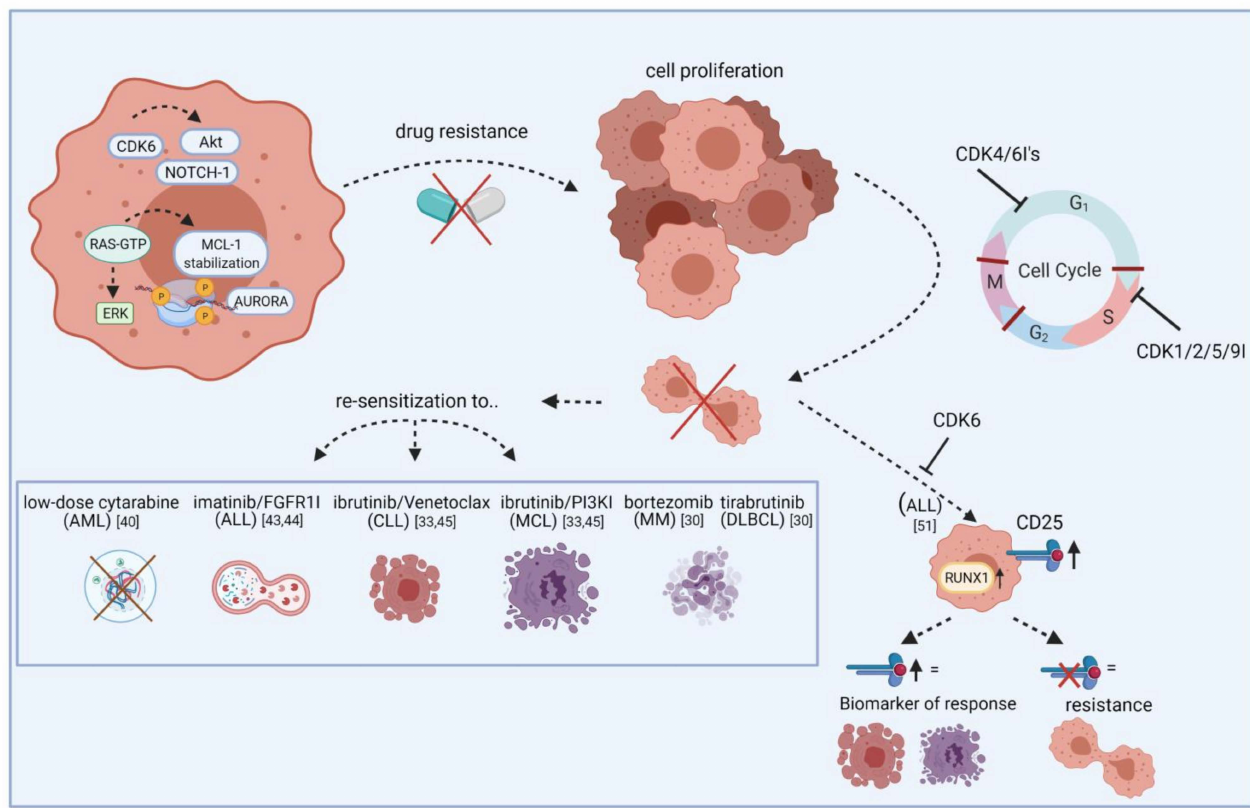
Figure 1. Re-sensitization of drug-resistant cells by CDK inhibitors. The scheme illustrates how CDKIs can conquer resistance of leukemic blasts towards targeted agents. Leukemic cells show frequent overexpression or constitutive activation of oncogenic kinases like AURORA and AKT. While these kinases mediate drug resistance via apoptosis inhibition or increased tumor cell proliferation, blocking specific CDKIs may help to make cells more vulnerable to certain approved drugs, including cytarabine, imatinib, and ibrutinib. This effect is likely mediated by cell cycle checkpoint blockade, resulting in impaired cell division and proliferation. Additionally, blocking CDKs induces CD25 abundance on ALL cells and this may act as a biomarker for response. Vice versa, lack of CD25 expression indicates resistance. FGFR1I, fibroblast growth factor receptor 1 inhibitor; PI3KI, phosphatidyl inositol 3 kinase inhibitor; MCL, mantle cell lymphoma; MM, multiple myeloma; DLBCL, diffuse large B-cell lymphoma. Created with